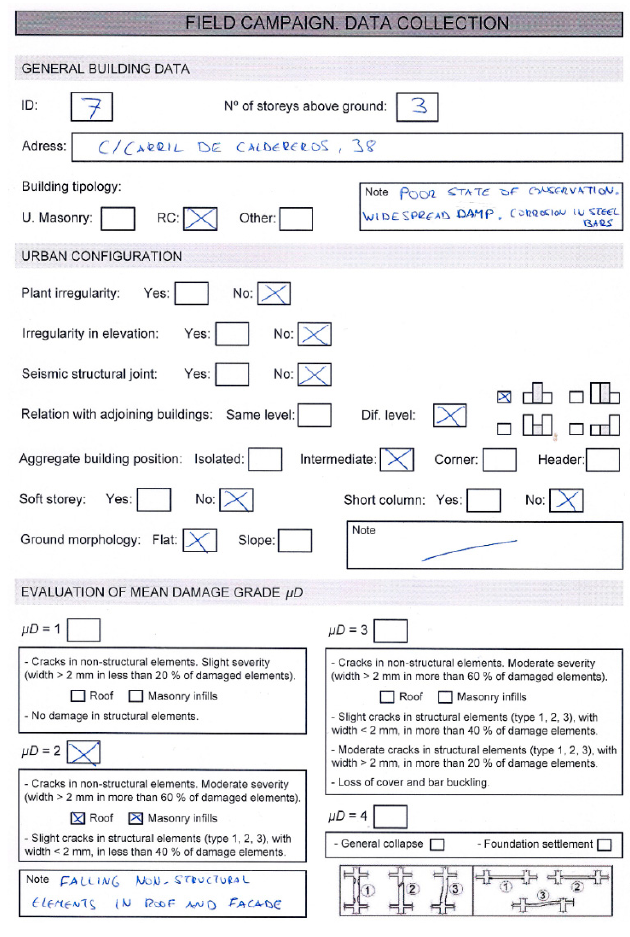
Figure 1. Example of a template used in the field campaign to collect data.